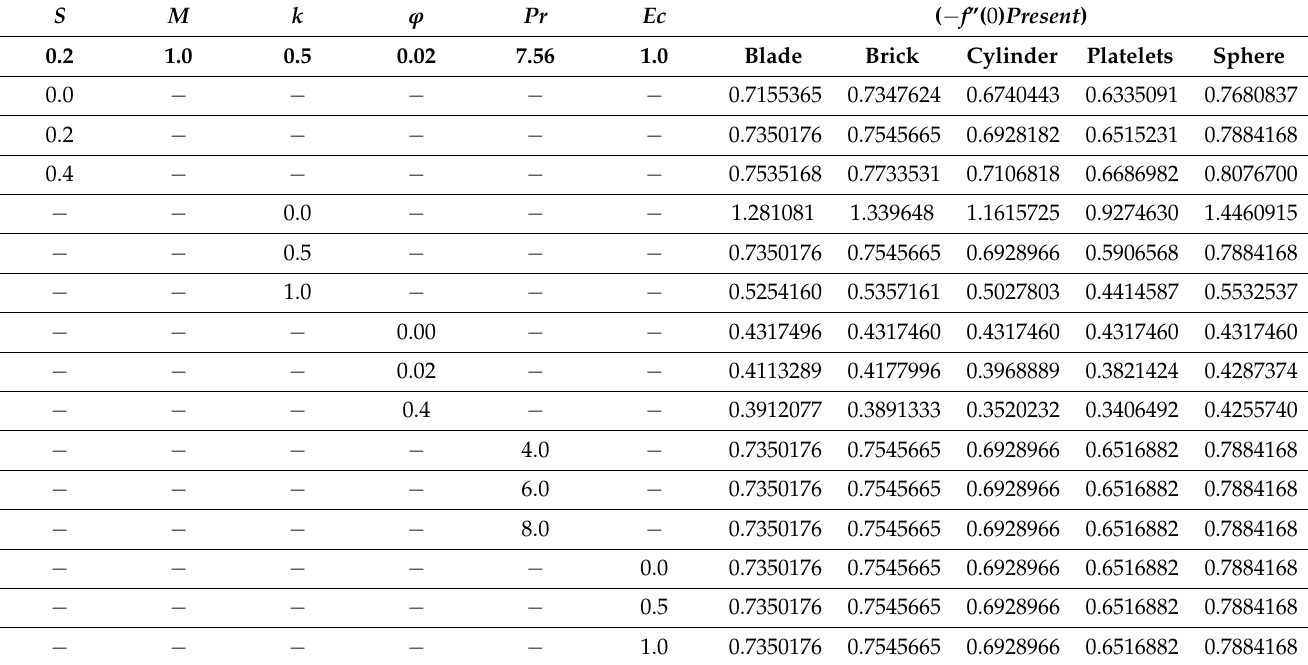
Table 3. The computed results for local skin friction.